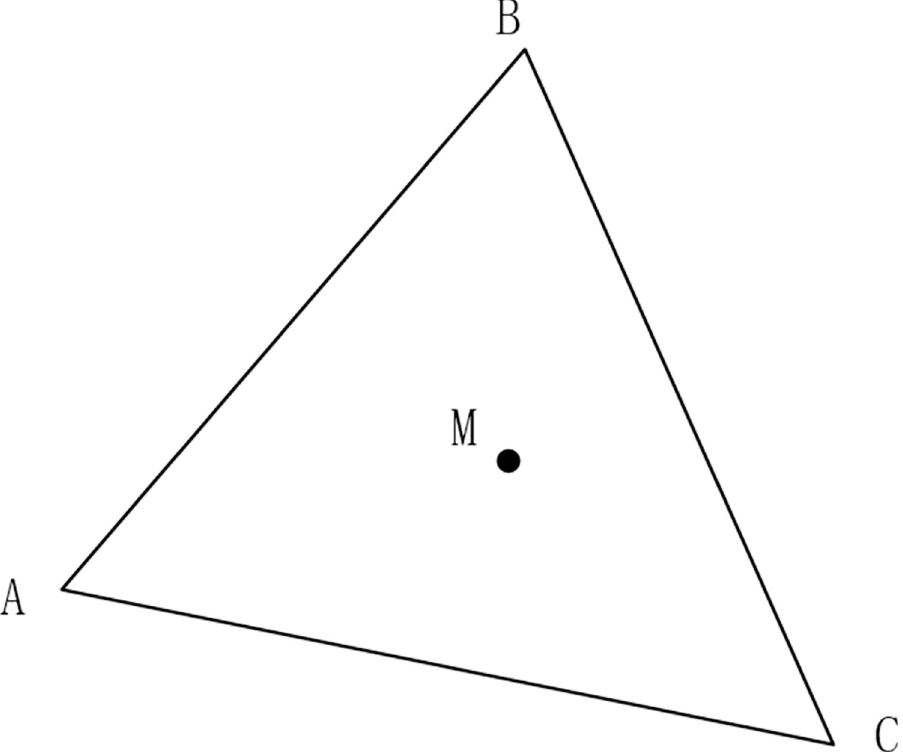
Fig 2. Diagram of the correlation among points and